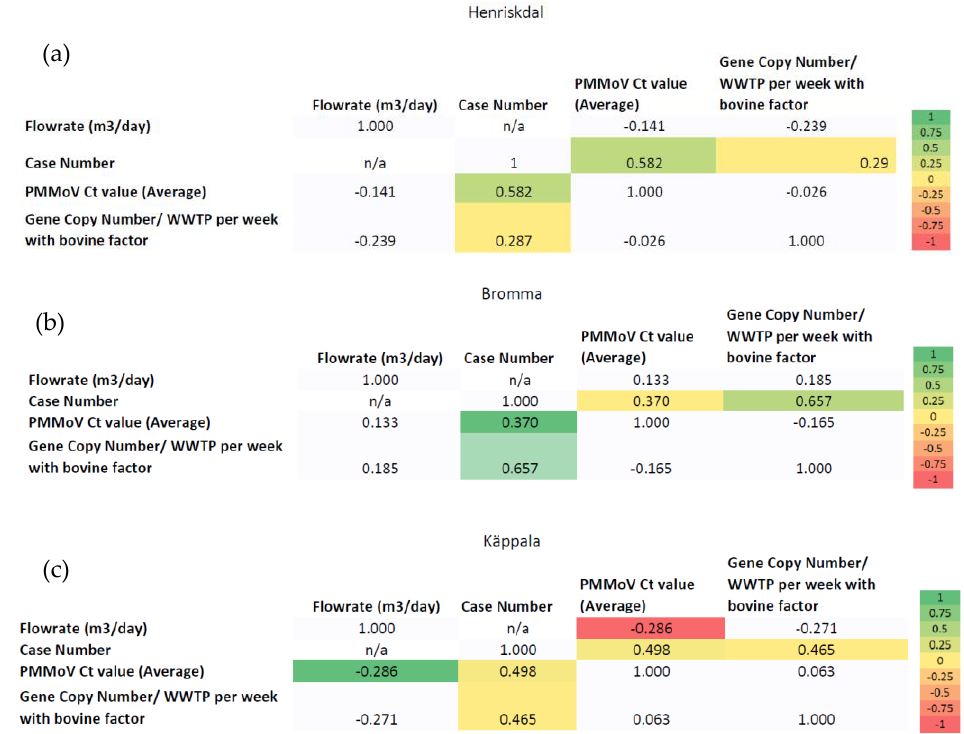
green (high correlation coefficient) and yellow (low correlation coefficient). The negatively corre- lated parameters are highlighted in the red boxes (n/a: not applicable).